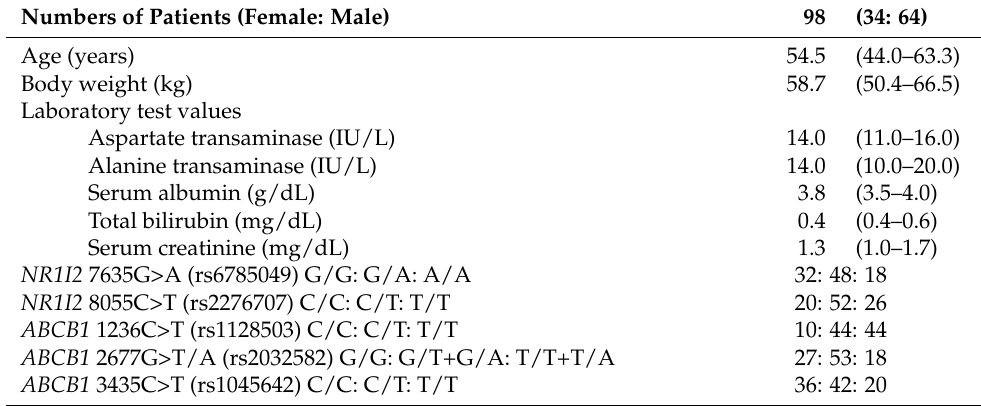
Table 1. Clinical characteristics of patients before beginning everolimus therapy.